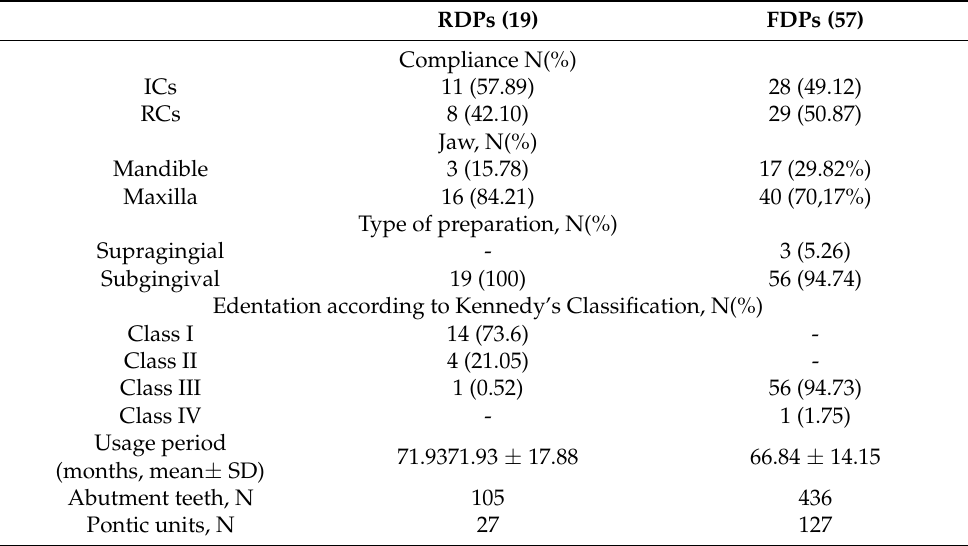
Table 2. Characteristics of the prosthesis.